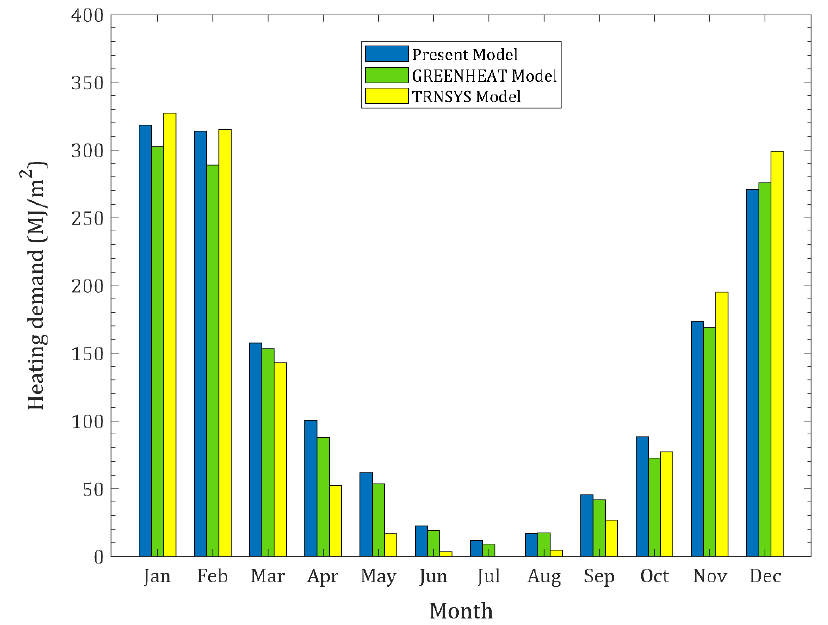
Figure 8. Comparison between the results of the present greenhouse model and those of GREENHEAT [69] and TRNSYS